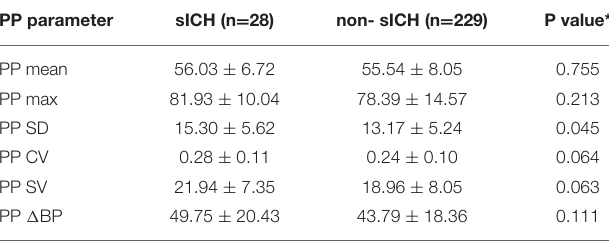
TABLE 3 | Blood pressure variability parameters between sICH and non- sICH.